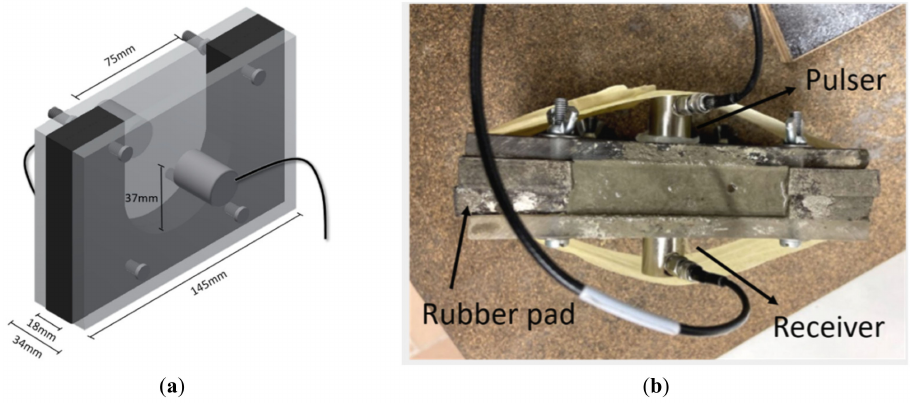
Figure 1. ( a ) Drawing of the ultrasound mould with acoustic sensors and ( b ) laboratory